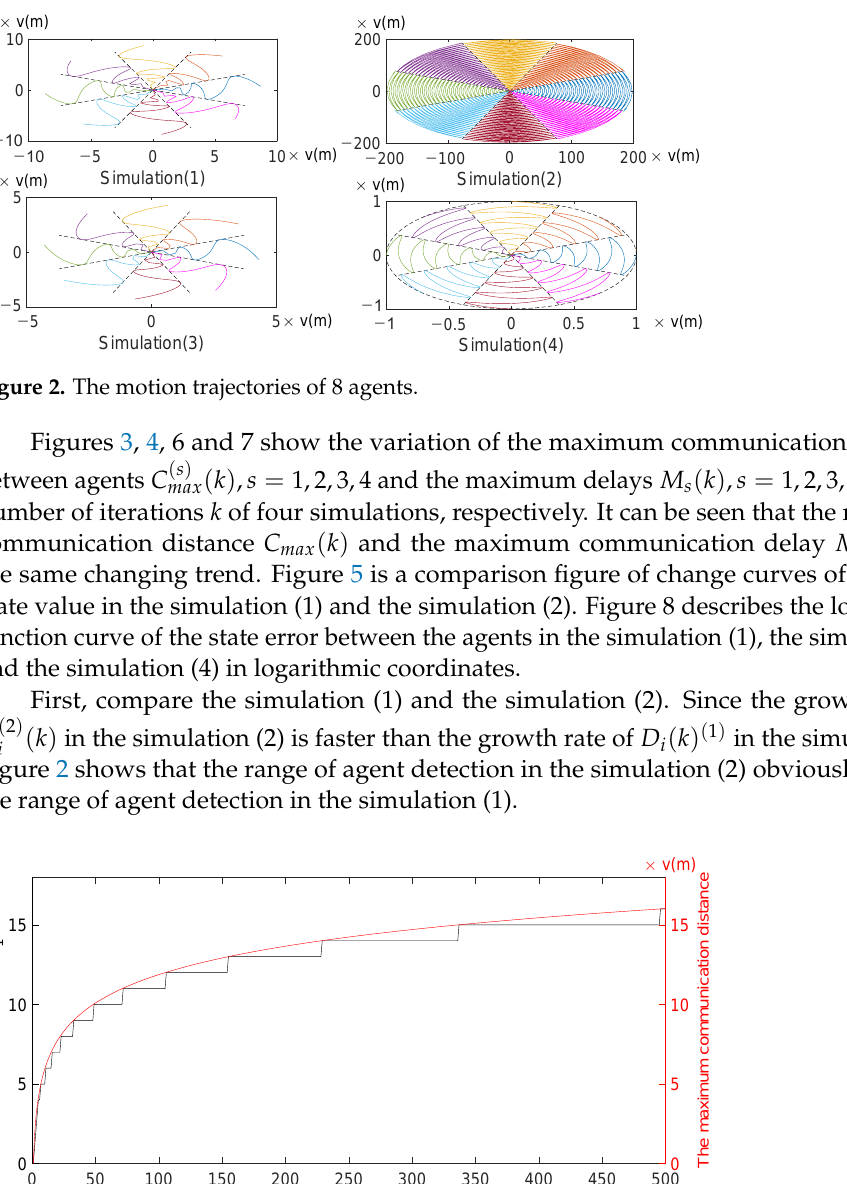
Figure 3. The maximum communication distances C M 1 ( k ) in the simulation